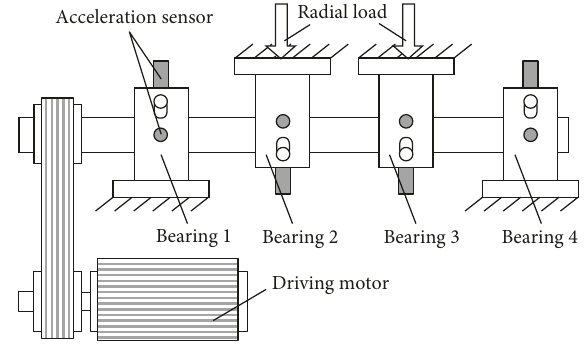
Figure 19: Schematic diagram of experiment